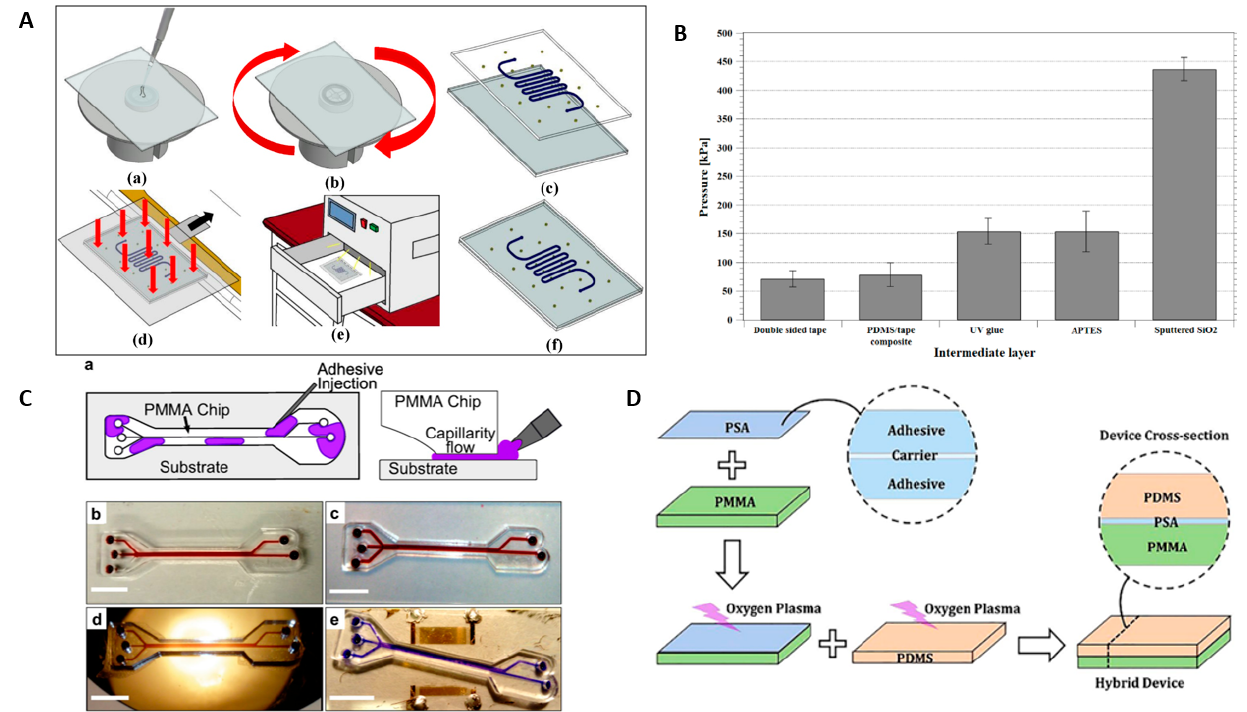
Figure 6. ( A ) Schematic of the adhesive bonding process Reprinted with permission from ref.